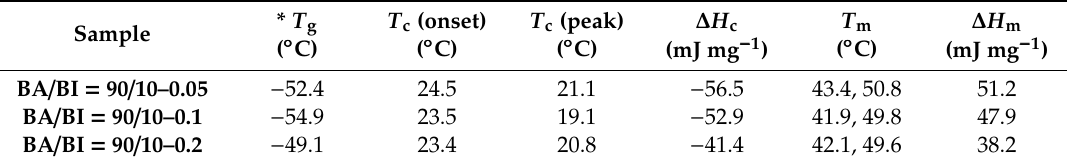
Table 8. Thermal property of PBABI copolyesters.